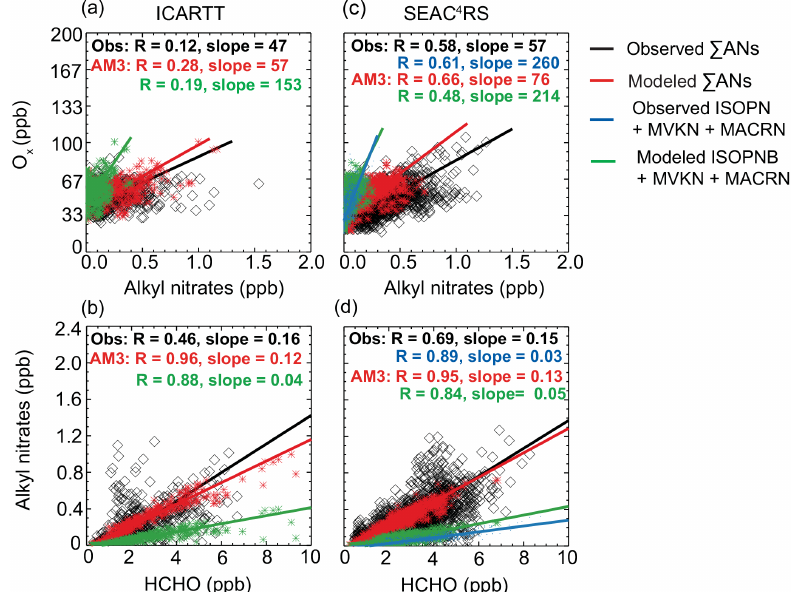
Figure 4. O x versus (cid:54) ANs correlation (a, c) and (cid:54) ANs versus formaldehyde correlation (b, d) within the boundary layer (<1.5km) during ICARTT (a, b) and SEAC 4 RS (c, d) . Observations are in black diamonds; model estimates from AM3 with ISOPNB hydrolysis are represented by red symbols. Green symbols represent the correlation using modeled ISOPN + MVKN + MACRN. Blue symbols represent the correlation using observed ISOPN + MVKN + MACRN from SEAC 4 RS. Solid lines are the reduced major axis regression lines.